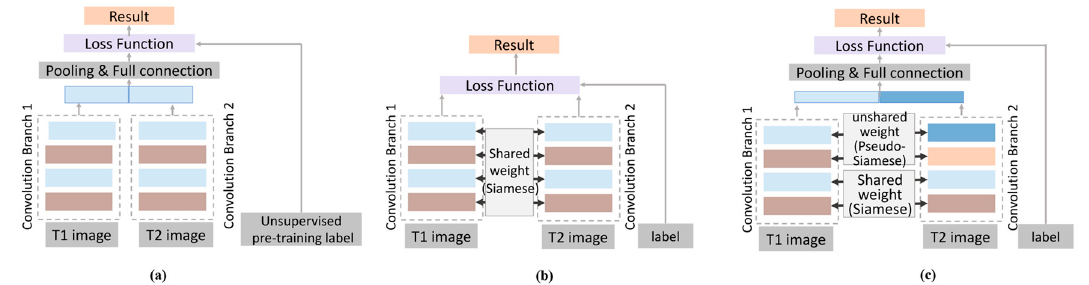
Figure 14. Schematic diagram of various dual-branch convolutional networks. ( a ) Symmetric convolutional coupling network (SCCN); ( b ) Siamese convolutional neural network (CNN); ( c ) pseudo-Siamese CNN.